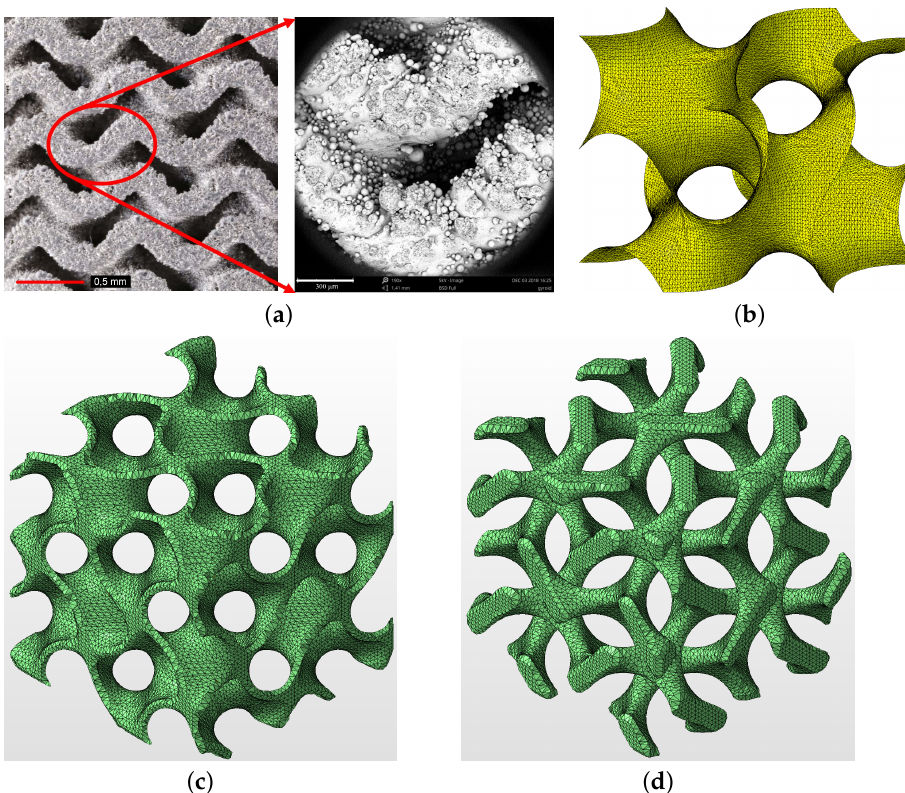
Figure 6. ( a ) Printed gyroid structure with no visible internal defects (left—photograph provided by high-resolution camera Canon 6D Mark II, right—microscopic image provided by electron microscope SEM Phenom XL), ( b ) example of one-cell gyroid surface with t = 0, ( c ) matrix phase gyroid with finite wall thickness δ w = 400 µ m, ( d ) inverted matrix phase gyroid assuming δ w = 400 µ m (( b – d ) were generated using Autodesk Netfabb